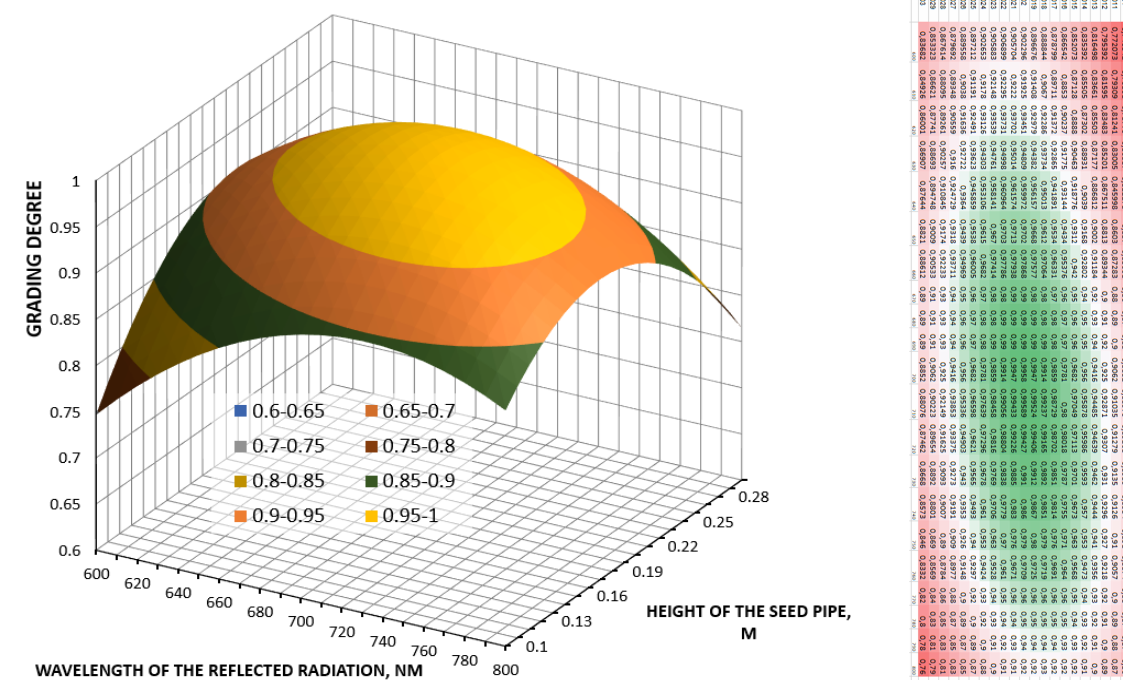
Figure 2. The response surface ( left ) and Excel–nomogram ( right ) determine the optimum when implementing a composite full–factor experiment when fixing the angle of incidence of the optical beam in the center of the plan at the level of 45°.